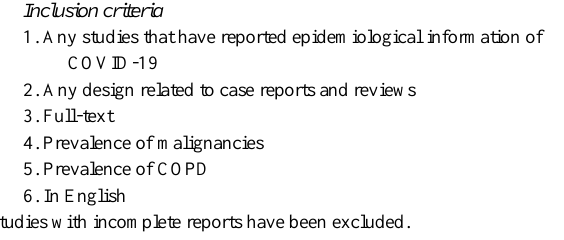
Figure 1. Study Attrition.